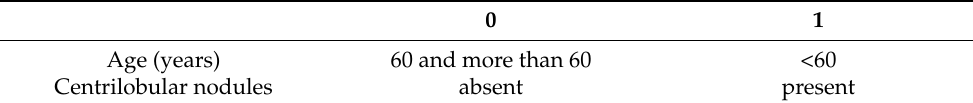
Table 4. Mycoplasma pneumoniae pneumonia-computed tomography age (MPP–CTA) scoring system.